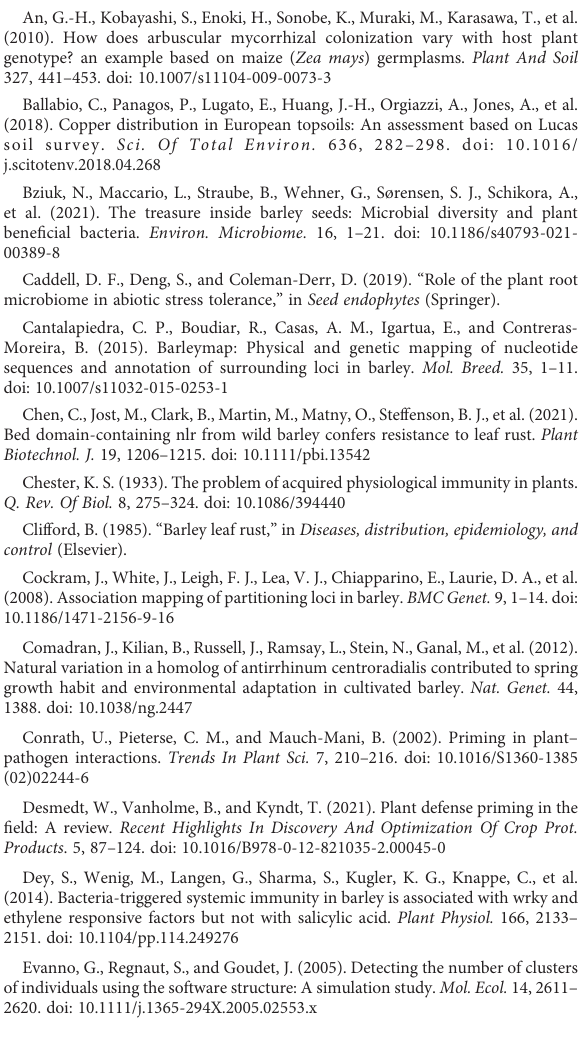
SUPPLEMENTARY FIGURE 1 Composition of the test panel of 200 spring barley accessions. Our study panel consisted of 111 two-rowed and 83 six-rowed accessions from the Genobar panel (Haseneyer et al., 2010; Pasam et al., 2012) comprising